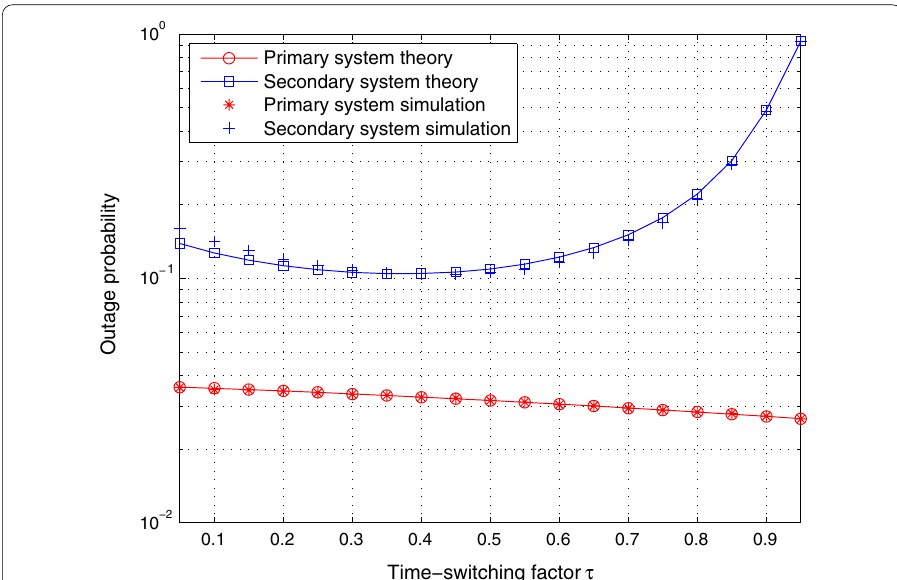
Fig. 3 Outage probability versus time-switching factor τ with power-splitting factor ρ = 0.5